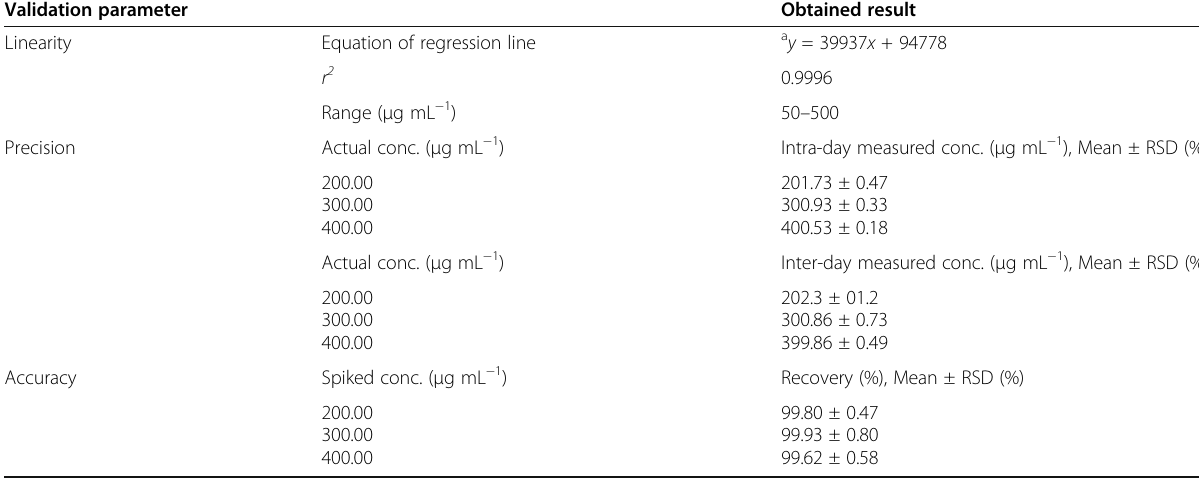
Table 3 Summary of method validation parameters Validation